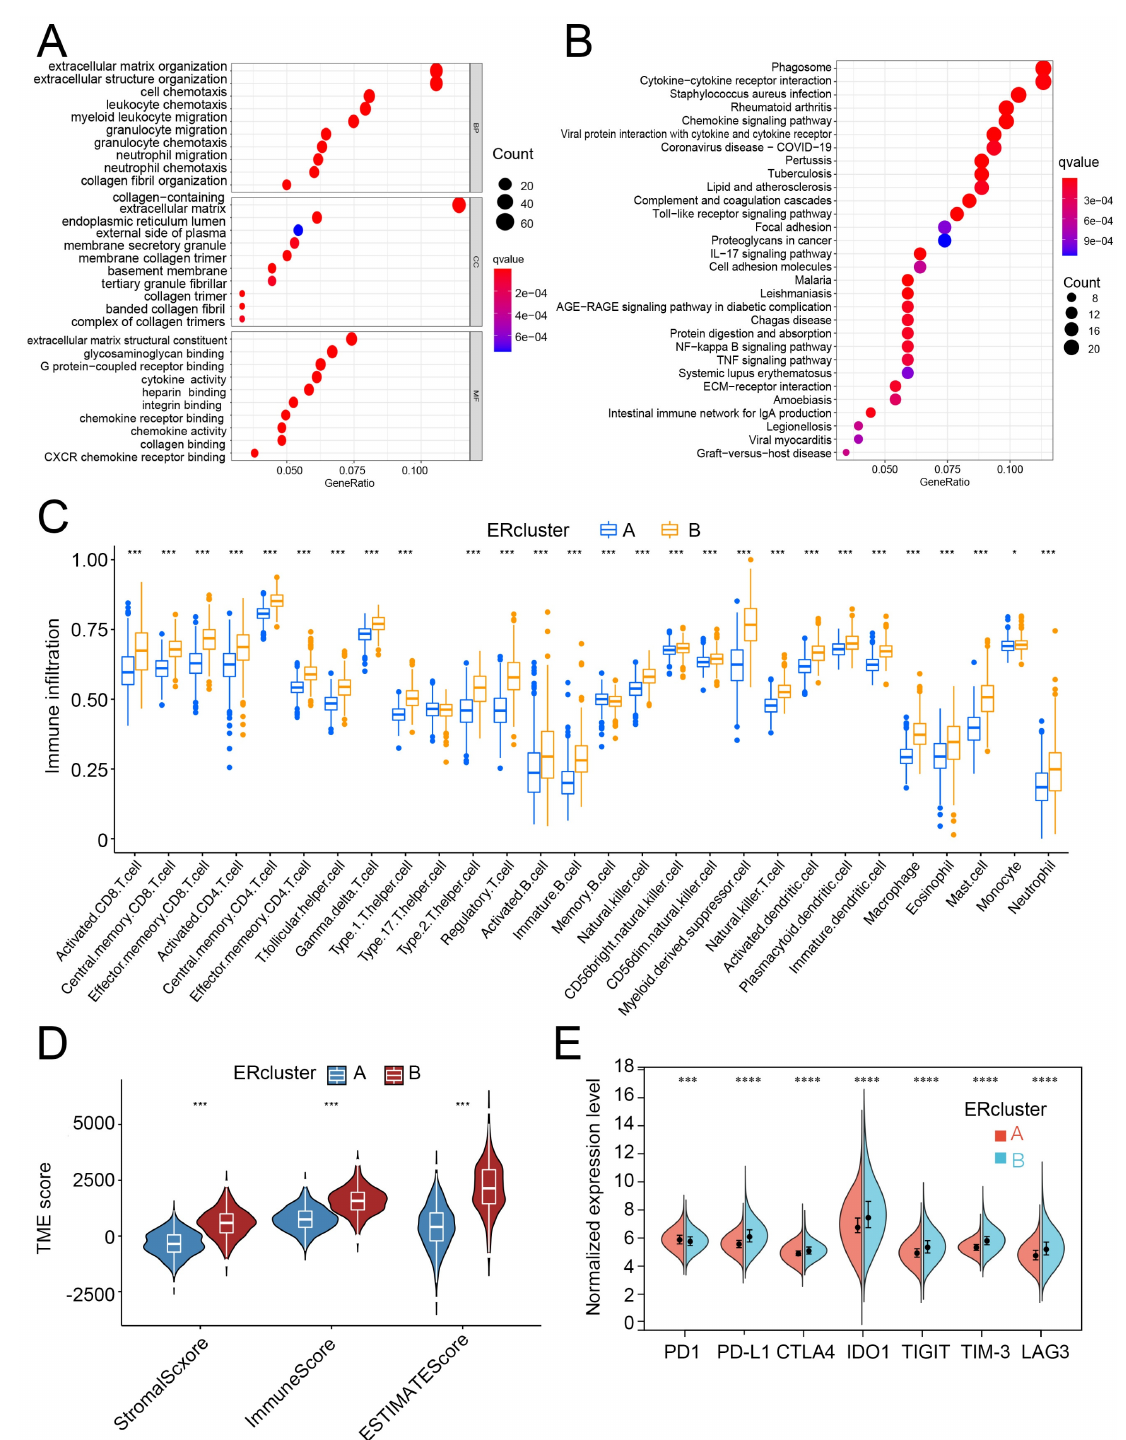
Figure 3. Functional analysis and the TME cell infiltration patterns between ERcluster A and B. ( A , B ) GO and KEGG pathways analysis of the identified 387 DEGs (Fold change value > 0.8 and p -value < 0.05). ( C ) The estimated infiltration abundance of 28 immune cells in ERcluster A and B. The upper and lower ends of the box represent the interquartile range, central bar represents the median value, and the dots stand for outliers (* p < 0.05, *** p < 0.001). ( D ) ESTIMATE scoring results of ERcluster A and B (* p < 0.05, *** p < 0.001). ( E ) Normalized expression level of common immune checkpoint genes ( PD1, PD-L1, CTLA4, IDO1, TIGIT, TIM-3, and LAG3 ) between ERcluster A and B (* p < 0.05, *** p < 0.001, **** p <